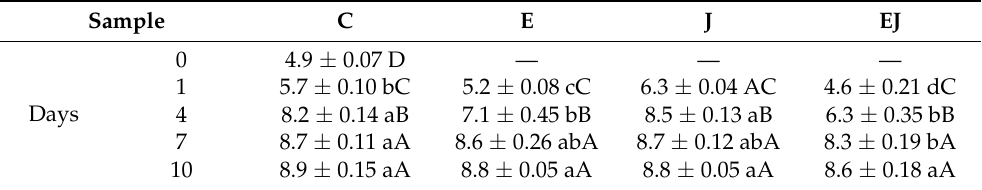
Table 4. Growth of AMB (log cfu/g) in chicken burgers for 10 days of storage: without inoculum € ); with 8% spray-dried extr € (E); with inoculum (J); with 8% of extract and inoculum (EJ). Sample C E J EJ 0 Days